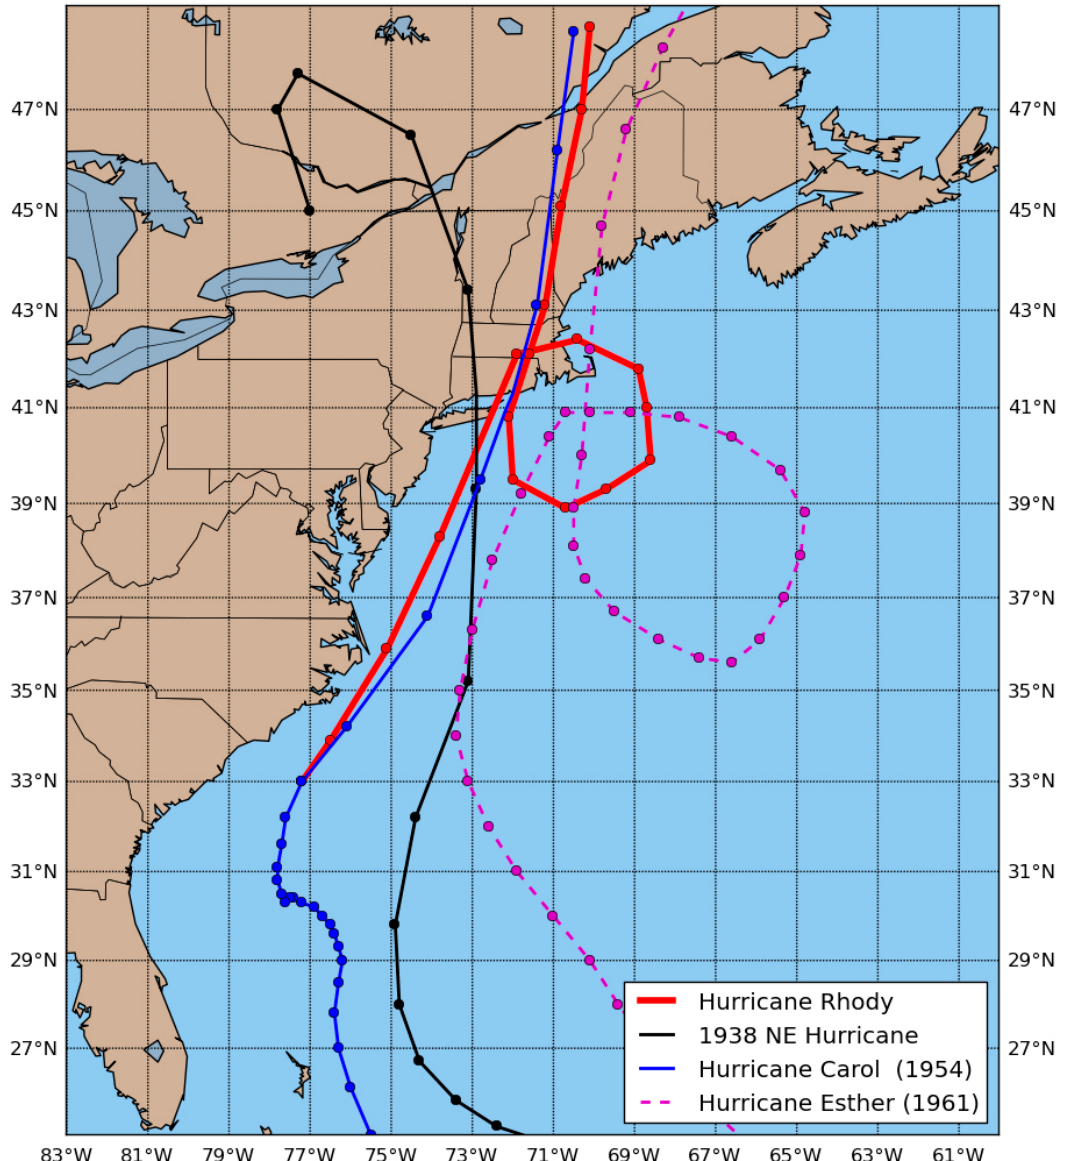
Figure 4. Track of Hurricane Rhody and those of three historical hurricanes whose characteristics were used as the basis for Rhody. The dots on the tracklines represent the storm positions at 12-h intervals. Maps of wind speed magnitude at intervals of 6 h during a time period bracketing the first landfall are shown in Figure 5. The storm approaches New England with a forward speed of approximately 20 m / s (39 knots) with maximum wind speed of approximately 57 m / s at landfall (Figure 5a,b). At landfall (Figure 5b), the e ff ect of land is apparent in the large reduction in wind speed over the northern half of the storm. Six hours after landfall (Figure 5c), the storm slows considerably, and over the next six hours (Figure 5d), it starts to move slowly to the south, the beginning of the loop that will eventually bring a second